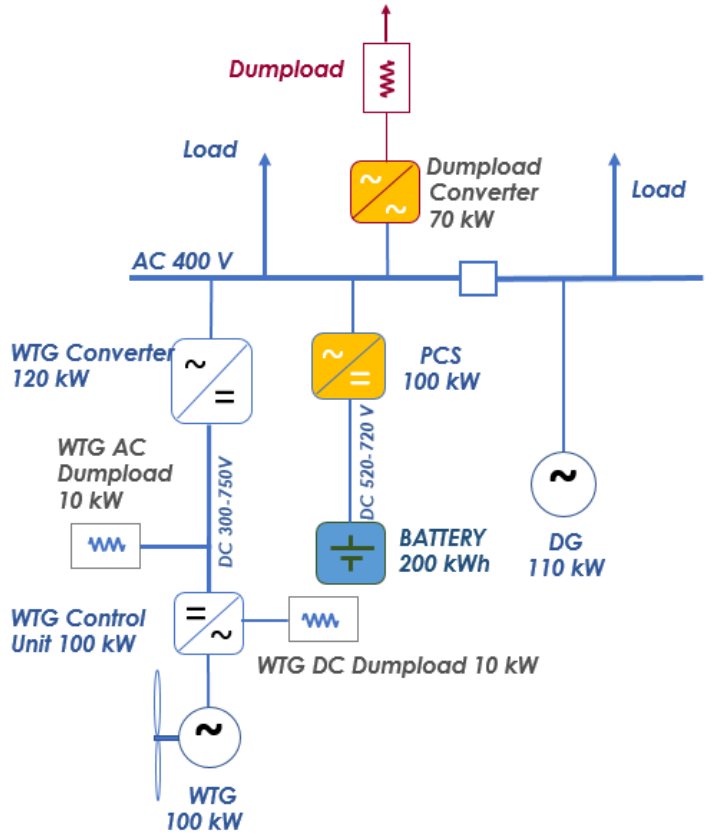
Figure 5. Structural scheme of the wind–diesel hybrid system.